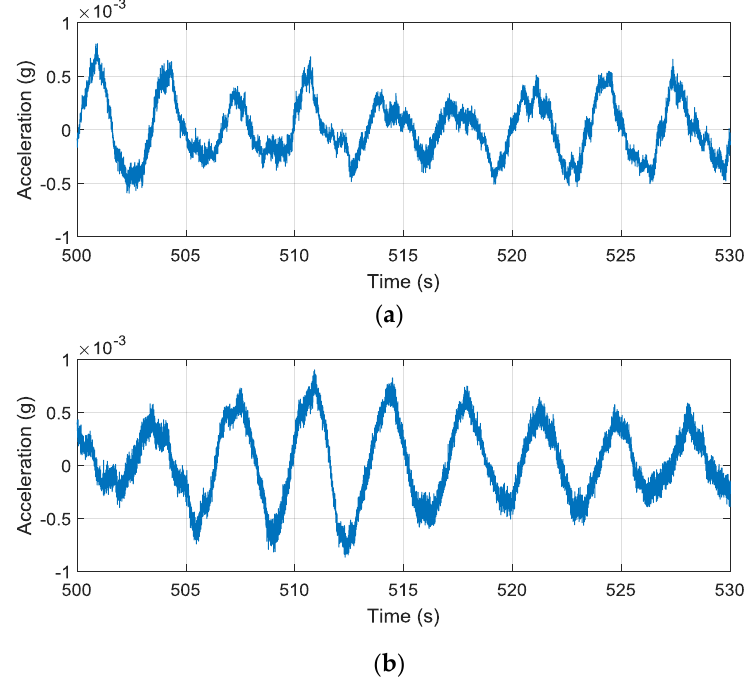
Figure 4. Measured acceleration time histories of Central Park 103: ( a ) x-direction and ( b ) y-direction.